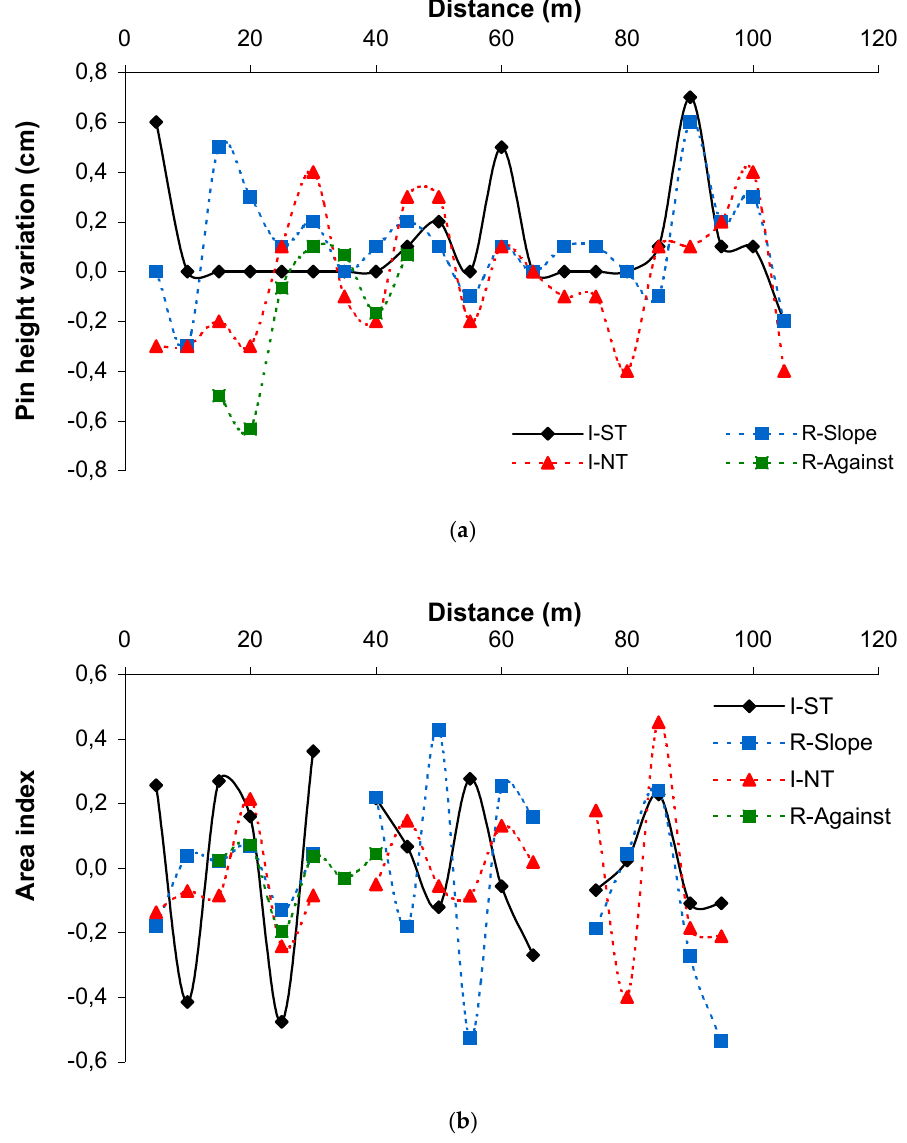
Figure 4. Pin height variation ( a ) and area index ( b ) over a year (May 2018 to April 2019) timespan for the treatments imposed in the Rías Baixas vineyard. Positive values of the area index indicate erosion, whereas negative values indicate soil deposition. R-Against: Rain-fed without soil tillage and rows oriented against the terrain slope; I-NT: Irrigated to cover 30% of reference evapotranspiration (ET o ) without soil tillage; I-ST: Irrigated to cover 30% of ET o with soil tillage and herbicide application to maintain soil without the protection of a vegetal cover; and R-Slope: Rain-fed without soil tillage and rows oriented in favor of the terrain slope. The area index ranged from −0.53 (deposition area) to 0.45 (erosion area), and was different among treatments (Figure 4b). Those treatments in which soil was covered by native vegetation recorded negative erosion rates, I-NT = −0.03 ± 0.03 Mg ha −1 and R-Against = −0.17 ± 0.00 Mg ha −1 , except for R-Slope = 0.10 ± 0.02 Mg ha −1 . In contrast, the treatment in which soil was tilled registered positive erosion rates: I-ST = 0.10 ± 0.01 Mg ha −1 .